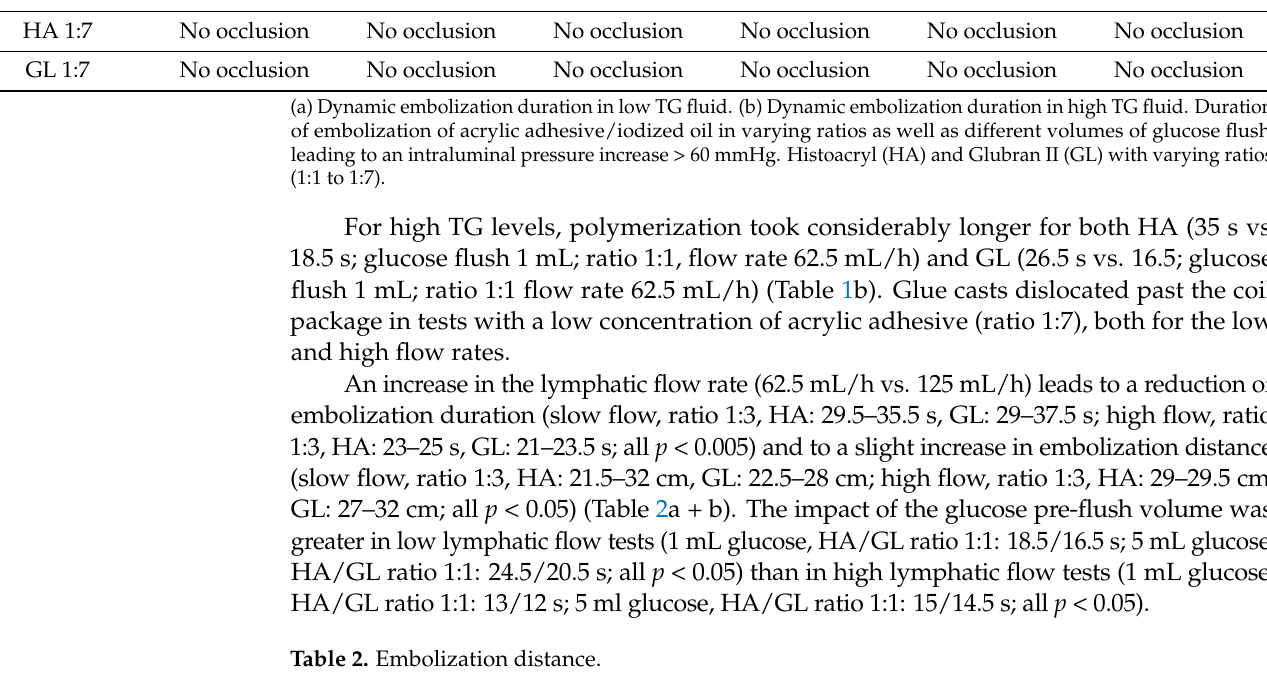
Table 2. Embolization distance. (a) Dynamic Embolization Distance in Low TG Fluid. Flow Rate 62.5 mL/h Flow Rate 125